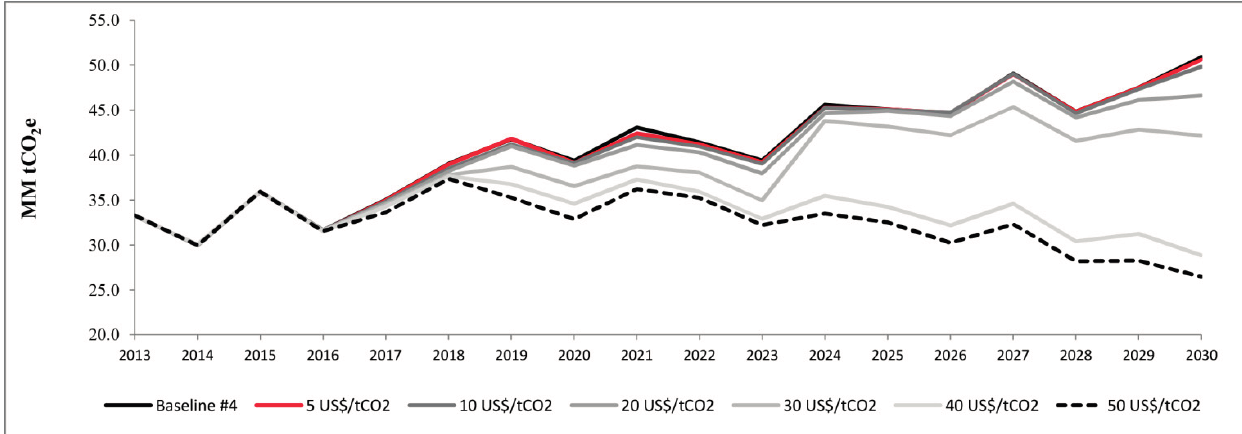
Figure 10. Emissions for baseline scenario #4 in comparison to different scenarios of carbon tax (MM =